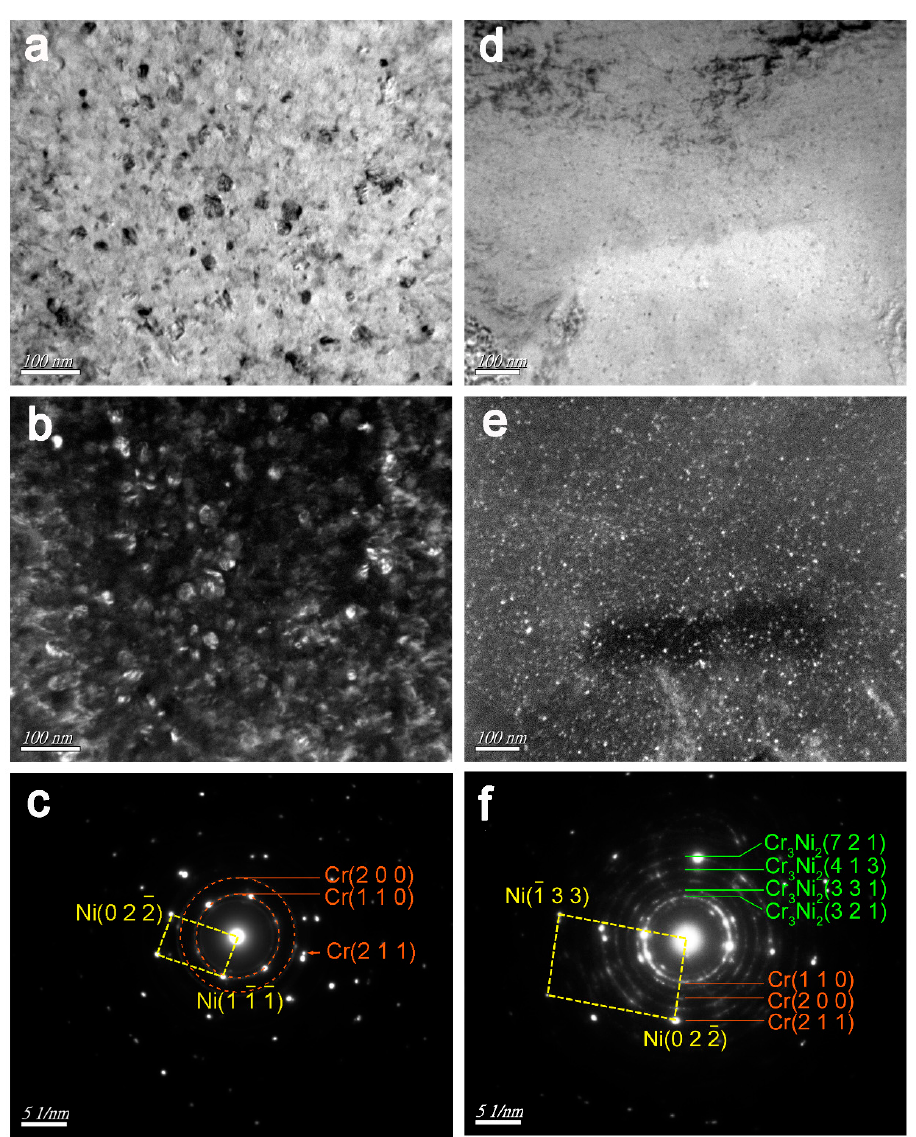
Figure 5. TEM micrographs of the HCPEB-irradiated Cr-Ni alloying layer of 10 pulses ( a ) bright field, ( b ) dark field, and ( c ) the corresponding SAED; 20 pulses ( d ) bright field, ( e ) dark field, and ( f ) the corresponding selected area electron diffraction (SAED).